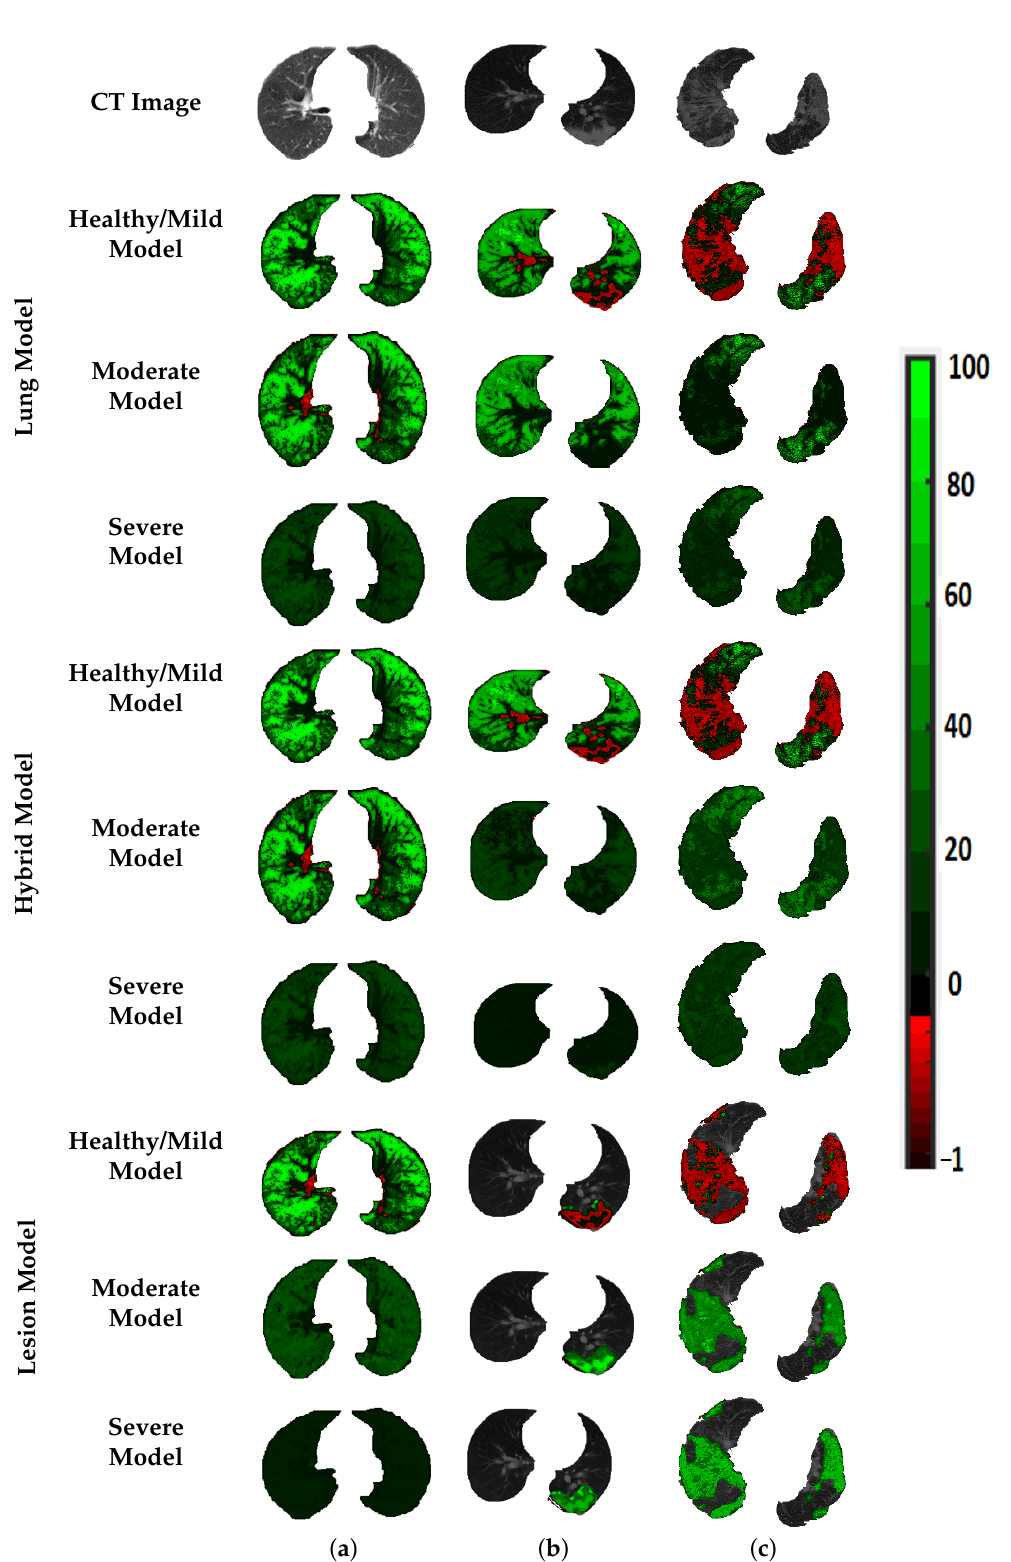
Figure 6. An illustrative color map example of Gibbs energies for ( a ) healthy/mild, ( b ) moderate, and ( c ) severe; tuned using healthy/mild, moderate, or severe COVID-19 lesions; applied to the lung (2nd–4th rows), hybrid (5th–7th rows), and lesion (8th–10th rows)